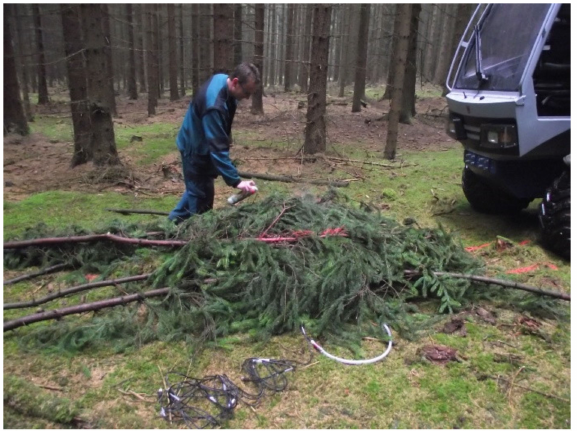
Figure 4. Preparation of logging residues into the assumed machine driving track.